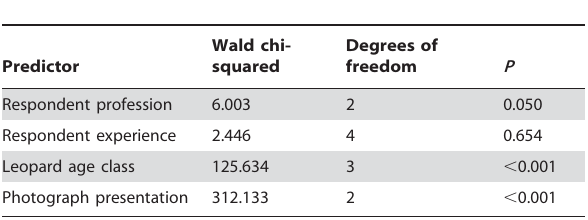
Table 2. Results of generalized linear models assessing the likelihood of survey respondents assigning photographs of male leopards to their correct age